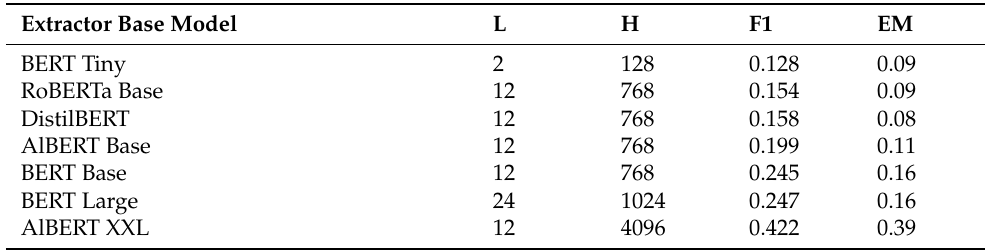
Table 4. End-to-end performance with Amazon Kendra as the retriever. L and H are hyperparameters for the extractor’s base